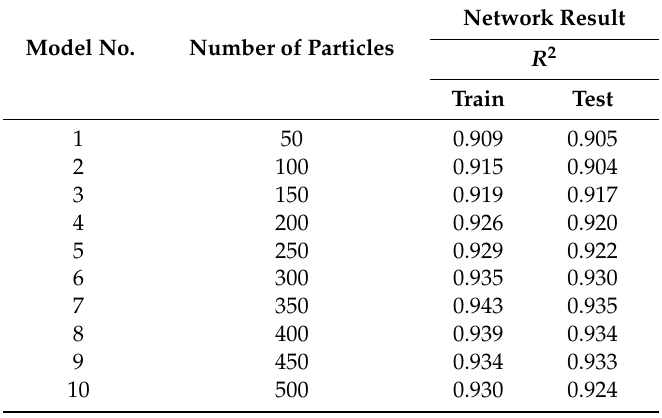
Table 4. Testing the di ff erent values of number of particles with their R 2 .